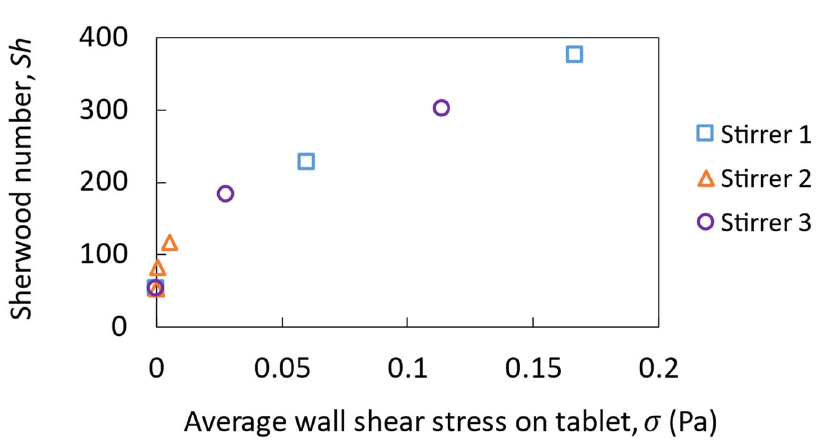
Figure 12. Sherwood number as a function of the average wall shear stress derived from the simu ‐ lation results.